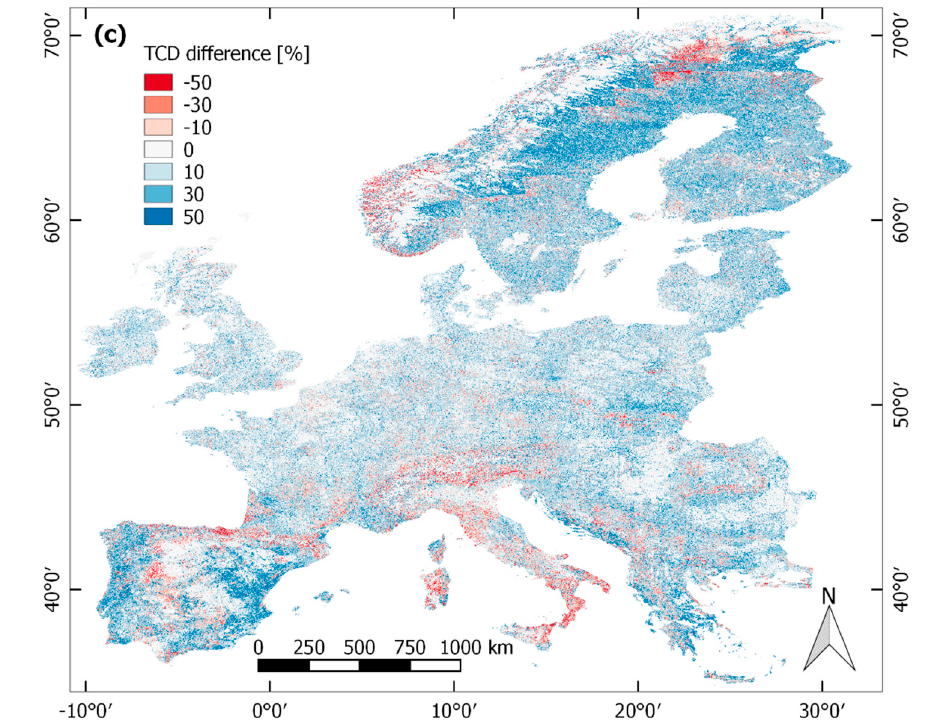
Figure 11. Overview of the tree cover density (TCD) maps from ( a ) Sentinel-1, ( b ) Copernicus High Resolution Layers (HRL) and ( c ) the difference map between the two datasets (Copernicus HRL map was subtracted from Sentinel-1 TCD map).